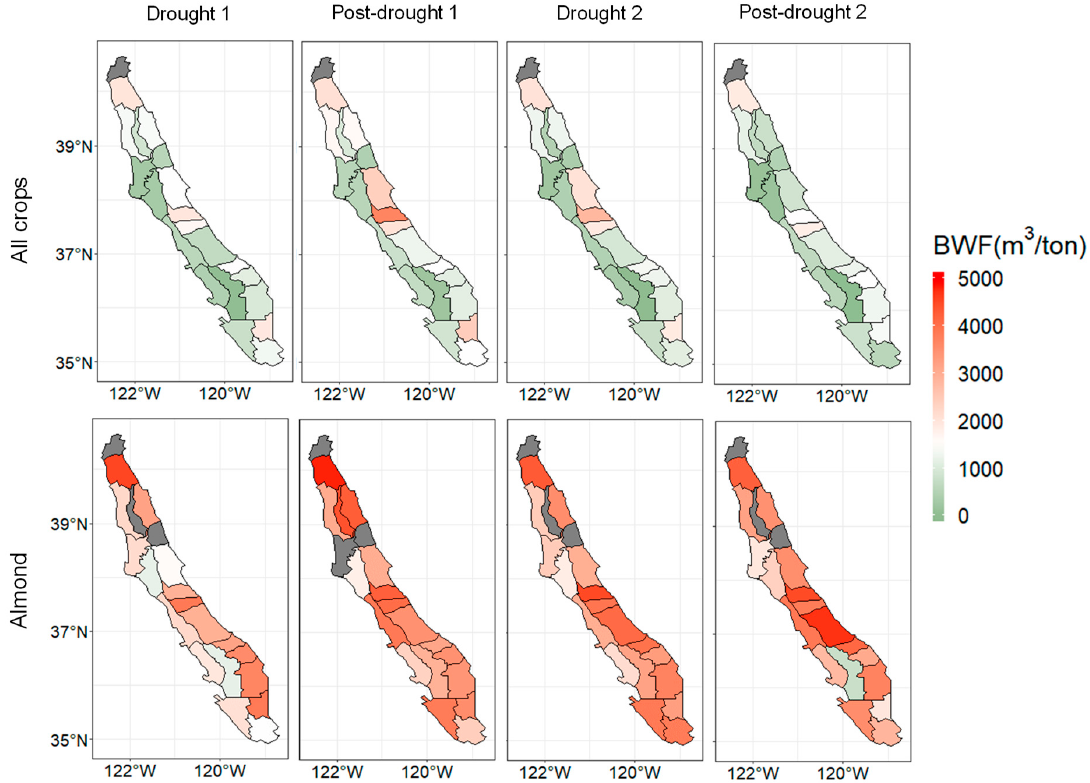
Figure 9. Blue Water Footprints for all crops ( top row) and almond crops ( bottom row) during four study periods. Grey color indicates no-value, which is due to a lack of explicit agricultural crop grids in a subregion.